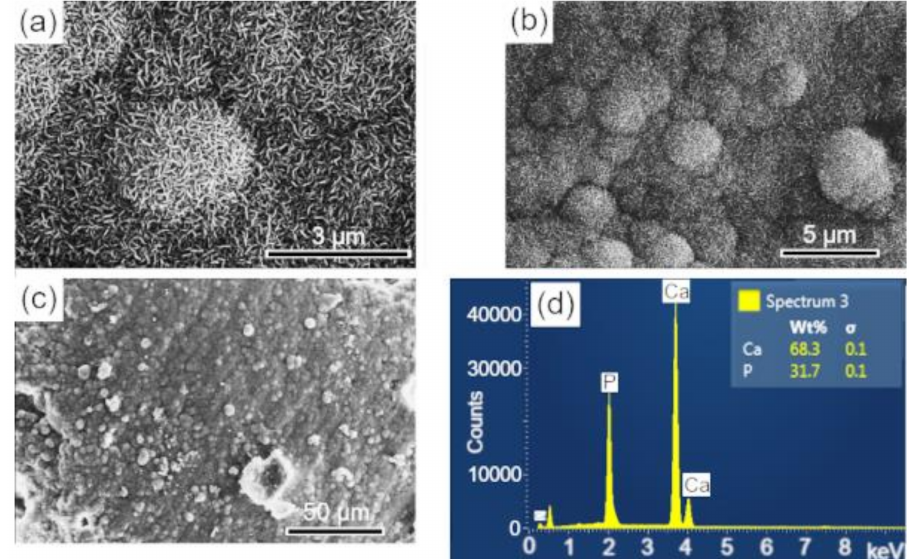
Figure 10. SEM imagens of the scaffold surface (BCP-CD.) after 28 d of immersion in SBF, showing a characteristic morphology of apatite nucleation in bioactive materials: ( a – c ) images with differ- ent magnifications and ( d ) EDS obtained on the sample surface. Ca = calcium; P = phosphorus; %wt = mass fraction; σ = mean